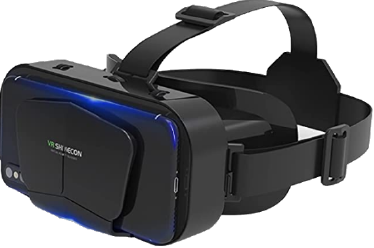
Figure 3. Virtual reality visor with smartphone